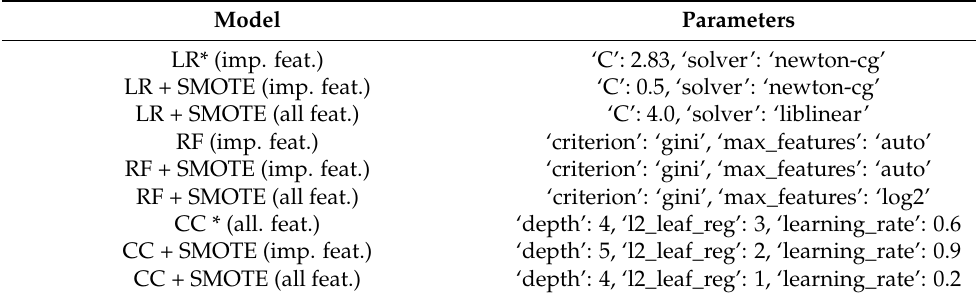
Table 2 lists the machine learning models and parameters used in the research. Table 2. Models and parameters.